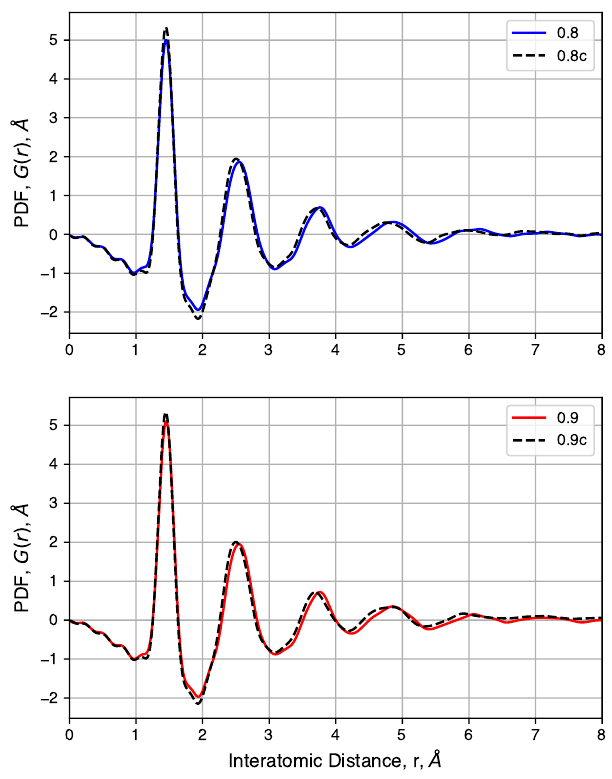
Figure 10. Pair distribution functions of samples with decreased initial density, before and after